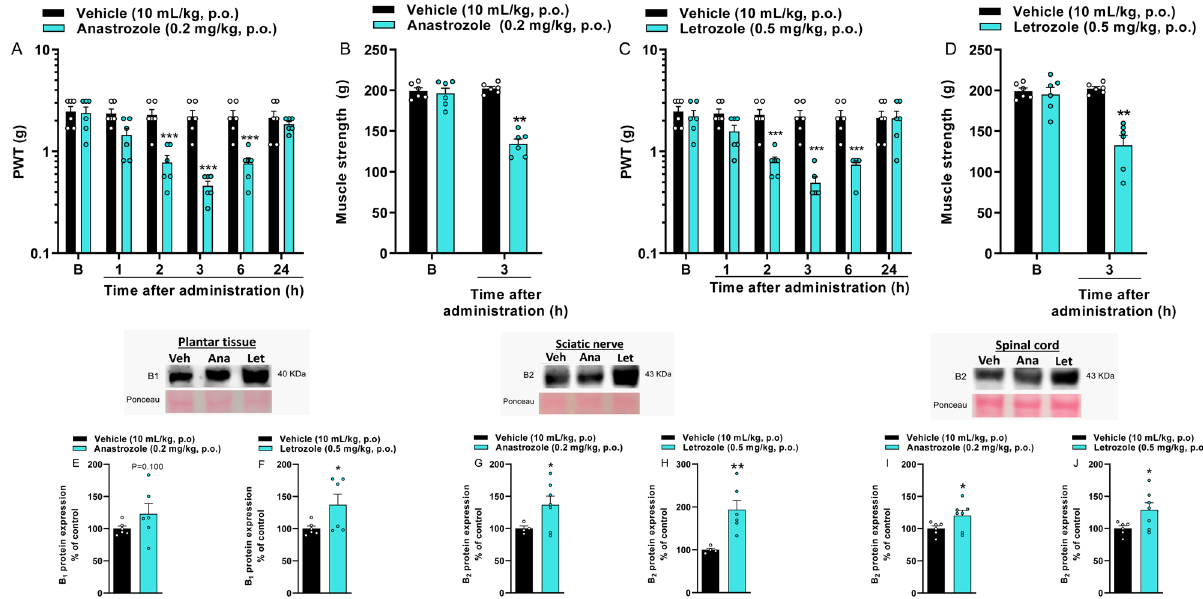
Figure 1. Aromatase inhibitors induce mechanical allodynia, reduce the muscle strength of mice and increase the kinin B 1 and B 2 receptor protein expression. Time-response curves to the mechanical allodynia ( A , C ) and the muscle strength at 3 h ( B , D ) after vehicle (10 mL/kg, p.o.), anastrozole (0.2 mg/kg, p.o. A , B ), or letrozole (0.5 mg/kg, p.o. C , D ) administration. (B) Denotes baseline mechanical threshold or muscle strength before drug administrations. Representative imagens of kinin B 1 receptor protein expression in the plantar tissue ( E , F ), kinin B 2 receptor protein expression in sciatic nerve ( G , H ) and spinal cord ( I , J ) at 3 h after vehicle (10 mL/ kg, p.o.), anastrozole (0.2 mg/kg, p.o.) or letrozole (0.5 mg/kg, p.o.) administration. Data are expressed as the mean + SEM. *P < 0.05; **P < 0.01; ***P < 0.001 when compared to the vehicle group; two-way repeated-measures ANOVA followed by Bonferroni’s post hoc test to the behavioral tests (n = 6/group; C57BL/6 mice) or Student’s t-test to the protein expression (n = 4–7/group; C57BL/6 mice). PWT paw withdrawal threshold. The original western blot images are available in Supplementary Fig.